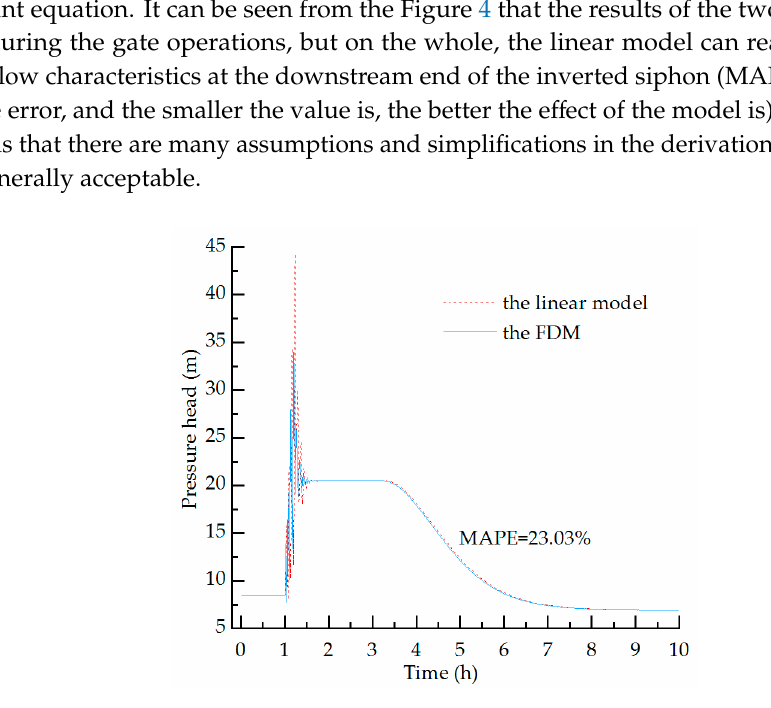
Figure 4. The verification to linear model.